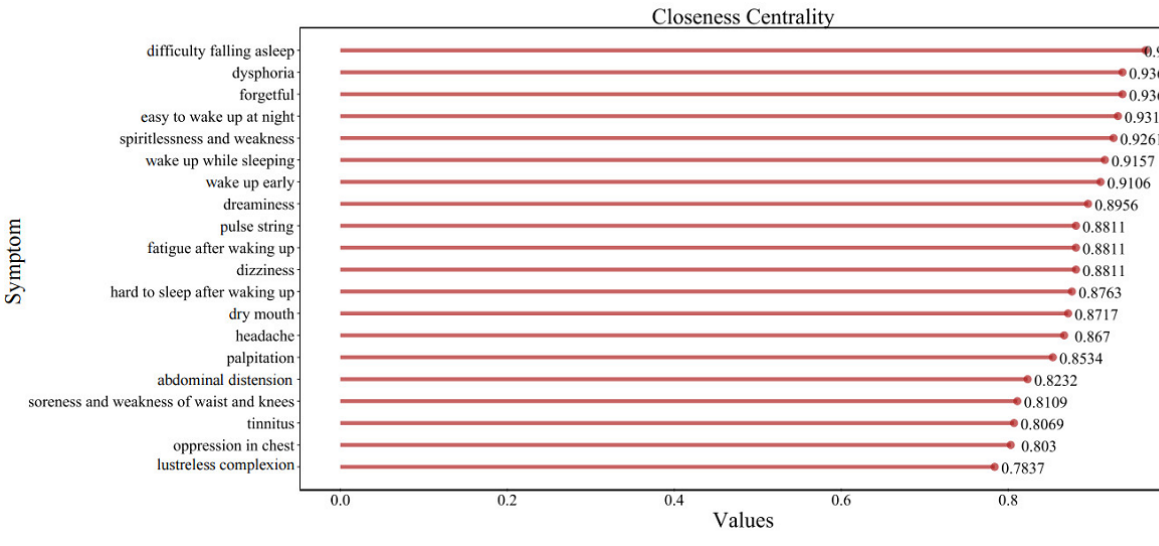
Figure 8. Betweenness centrality of